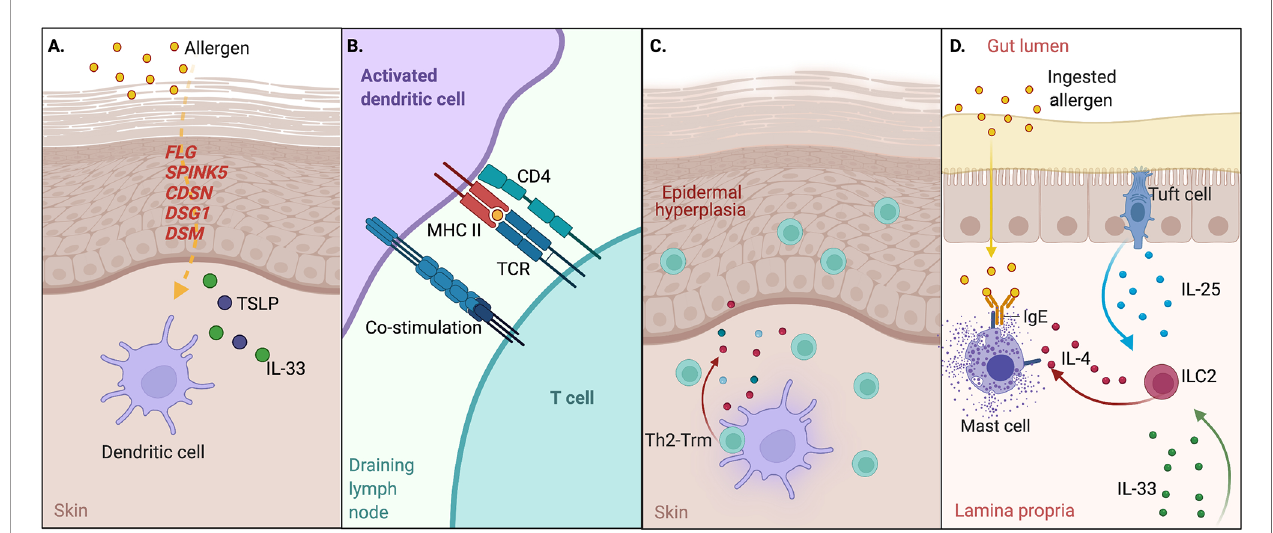
FIGURE 1 | Disrupted barrier function and the atopic march. (A) Disrupted skin barrier through primary disorders of the skin or external factors enable allergen entry; uptake by dendritic cells in the presence of alarmin signals such as TSLP and IL-33 promotes dendritic cell maturation and migration to the draining LN. Genes noted in red indicate monogenic IEI affecting this pathway. (B) Dendritic cells present allergen-derived peptide:MHCII to naive CD4 + T cells to induce Th2 effector cells and Tfh cells that drive IgE responses to allergen. (C) A portion of Th2 cells traf fi c back to skin and permanently reside as tissue-resident memory cells to drive local in fl ammation through release of type 2 cytokines such as IL-4, -5, and -13 upon re-encountering allergen. (D) Systemic IL-33 from keratinocytes and IL-25 from intestinal tuft cells synergize to activate ILC2s, which in turn produce IL-4 and activate mast cell degranulation (anaphylaxis) in response to oral allergen